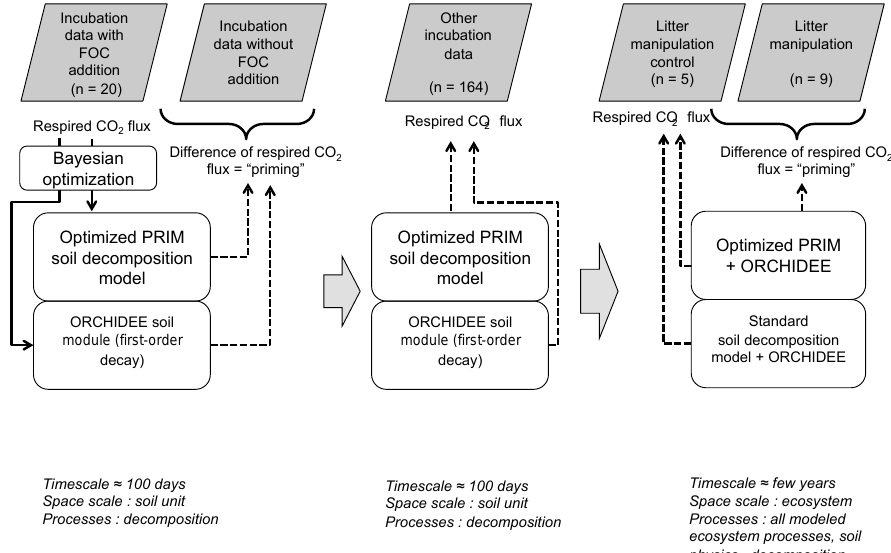
Figure 1. Summarizing scheme of the